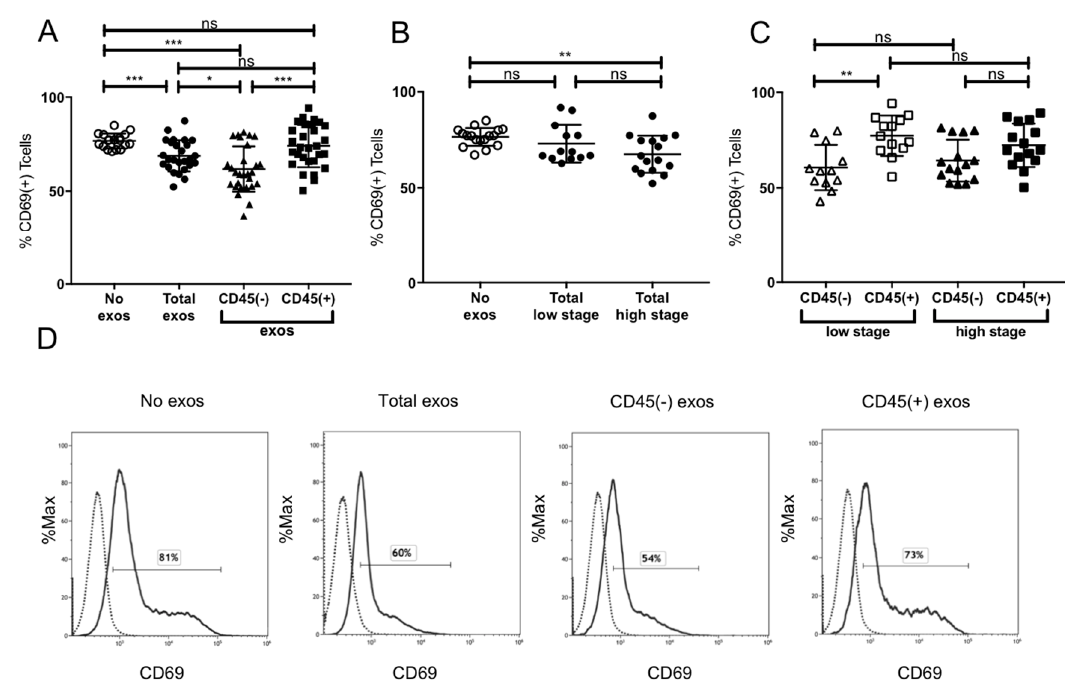
Figure 4. CD69 expression by activated CD8 + T cells. ( A ) CD69 expression after incubation with total, CD45( − ) and CD45( + ) exosome fraction of patients of all stages ( B ) CD69 expression after incubation with total exosomes of low stage vs. high stage patients. ( C ) Incubation of CD8 + T cells with CD45( − ) or CD45( + ) exosomes of low or high stage patients.; n = 29. p values were determined with Mann-Whitney test, with * p < 0.05, ** p < 0.005, *** p < 0.0005. Bars represent mean with standard deviation (SD). ( D ) Representative flow cytometry histograms depicting CD69 levels on CD8 + T cells after incubation with phosphate-bu ff ered saline (PBS), total, CD45( − ), and CD45( + ) exosomes (left to right) are shown. The solid line represents the CD69 signal, the dashed line represents the unstained control. The respective CD69 positive signal is displayed in percent.